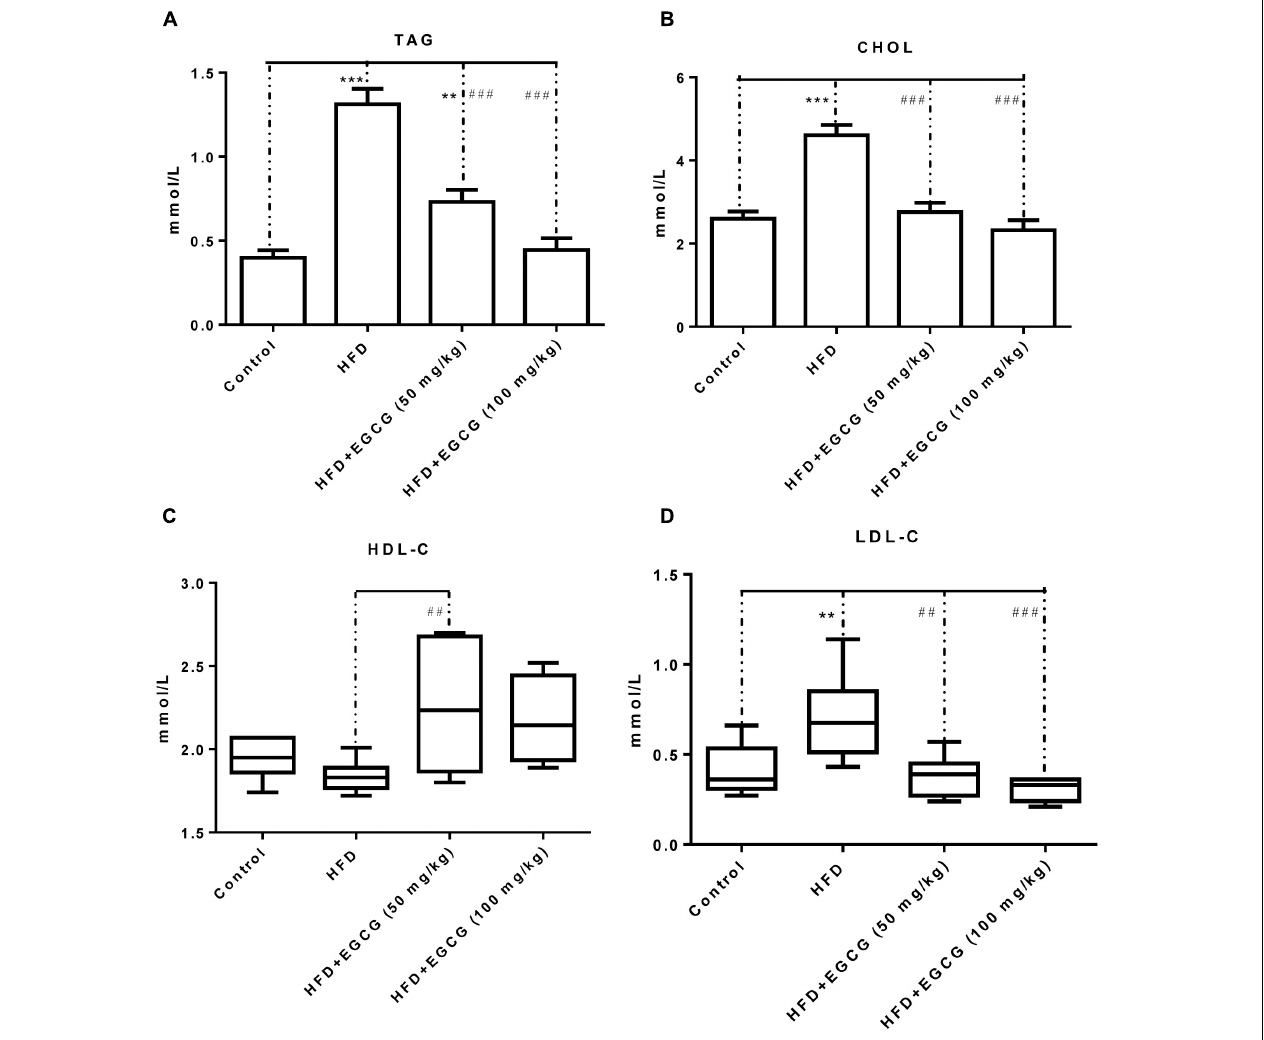
FIGURE 2 | EGCG alleviated HFD-induced hyperlipidemia in mice. (A) TAG; (B) CHOL; (C) HDL-C; and (D) LDL-C. Data were shown as mean ± SEM ( n = 6/7 each group). ∗ P < 0.05; ∗∗ P < 0.01; ∗∗∗ P < 0.001 vs. control. # P < 0.05; ## P < 0.01; ### P < 0.001 vs. HFD. § P < 0.05 vs. HFD + EGCG (50 mg/kg).